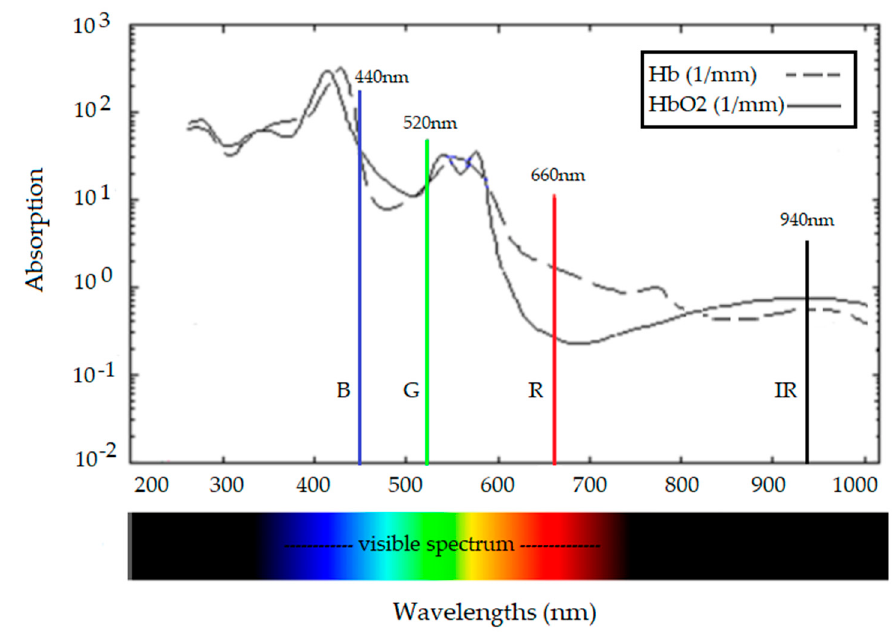
Figure 1. Schematic diagram of the proposed measuring systems (adapted from